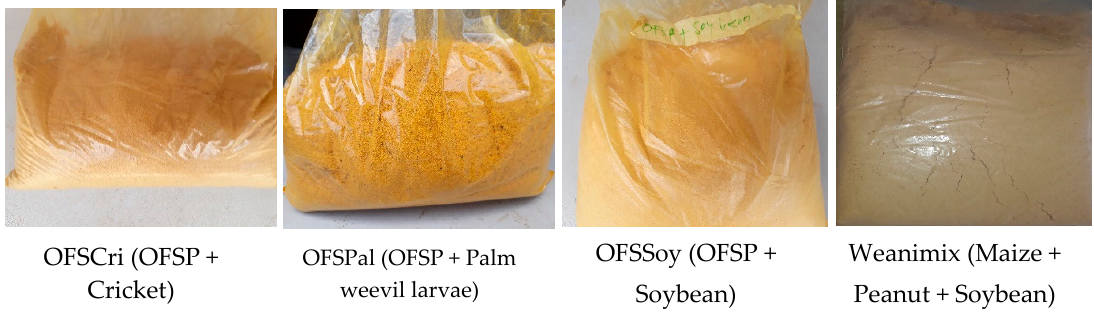
Figure 3. Color of orange-fleshed sweet potato (OFSP) based complementary foods and Weanimix.